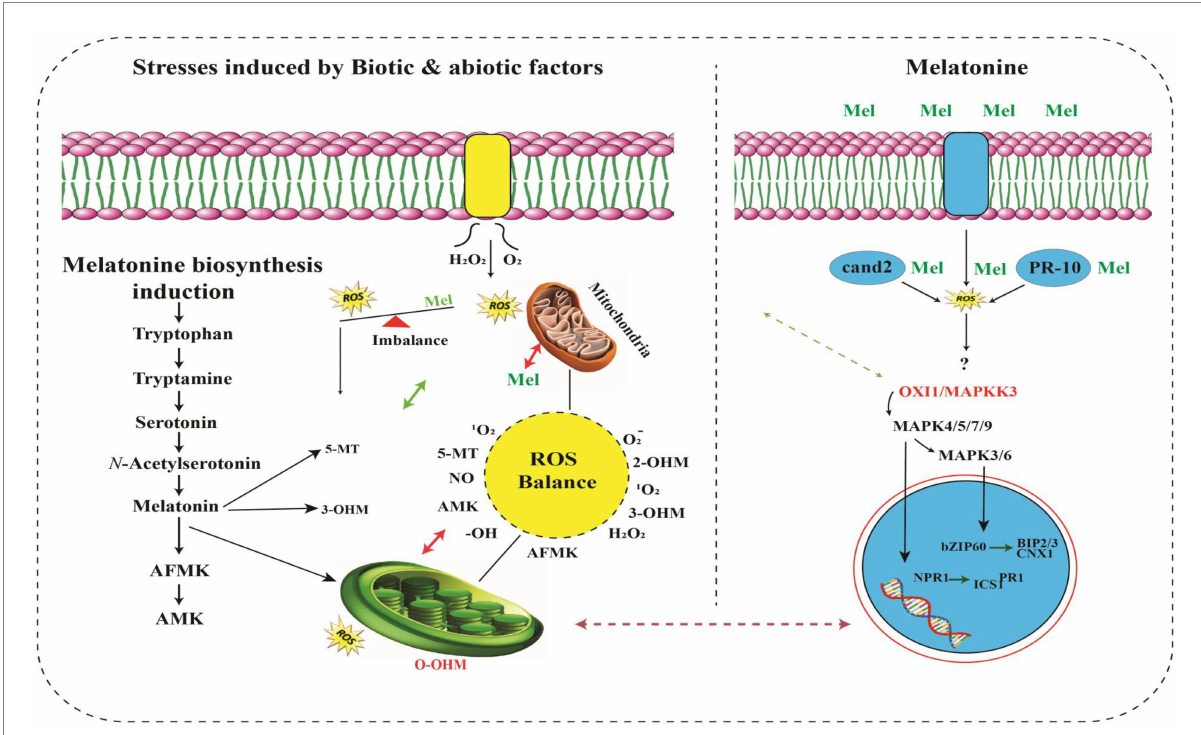
FIGURE 2 Overview of signaling pathways of melatonin and its metabolites (Back, 2021). MT activates MAPK cascade through OXI1/MAPKKK3– MAPKK4/5/7/9–MAPK3/6 . MAPK activation induces translocation of the SA receptor NPR1 into the nucleus to interact with several transcription factors, resulting in abiotic stress tolerance. Exogenously applied MT attenuates endoplasmic reticulum stress damage by increasing the expression of BIP2, BIP3 and CNX1 genes through the bZIP60 transcription factor. Kinase (RLK) works as a MT receptor responsible for further activation of the MAPK cascade. ROS burst occurs from RBOH under stress conditions. Thus, ROS are powerful inducers of de novo melatonin biosynthesis. MT further metabolizes into AFMK, AMK, 5-MT, 2-OHM, 3-OHM , which are potent antioxidants. Melatonin and its metabolites efficiently scavenge a range of ROS/RNS to maintain cellular ROS balance. Unlike ROS-mediated MAPK activation upon stress (Jalmi and Sinha, 2015), melatonin-mediated MAPK activation is independent of ROS, indicating that melatonin functions downstream of the ROS burst (Lee and Back, 2017a). In this figure, solid arrows indicate confirmed functions; dashed arrows indicate steps not yet